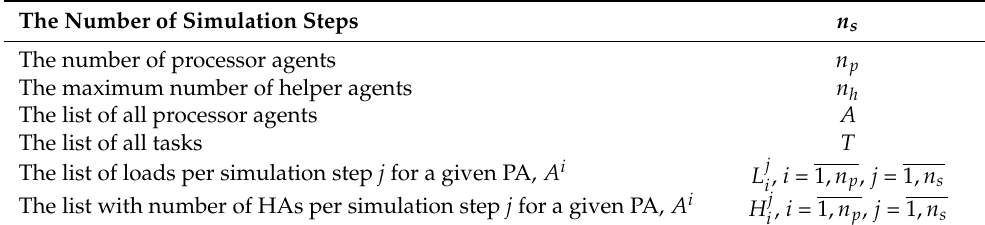
Table 1. The parameters used in the calculation of the